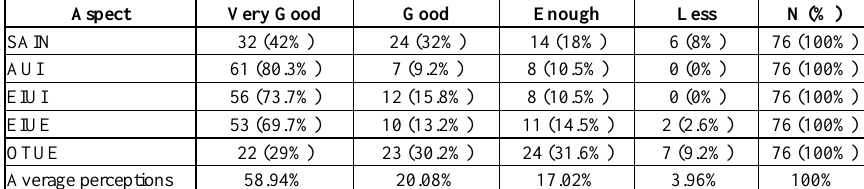
Table 3. Lecturers' perceptions related to the use of e-learning in teaching